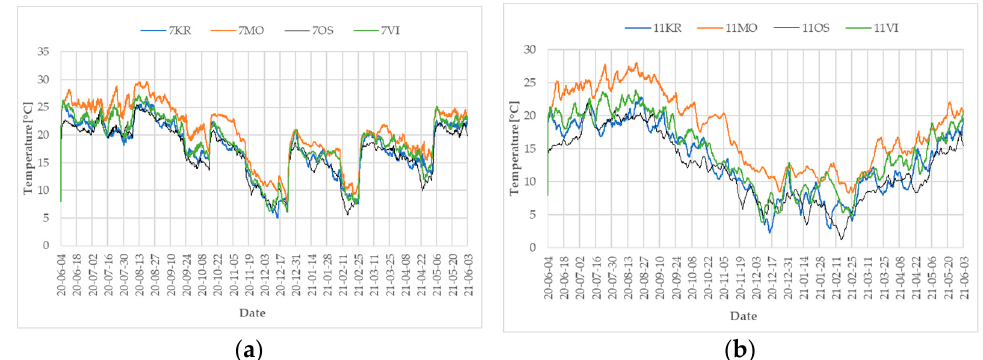
Figure 15. Ground temperature waveform, depending on the location of the test site, at points: ( a )—measurement point 7; ( b )—measurement point 11.